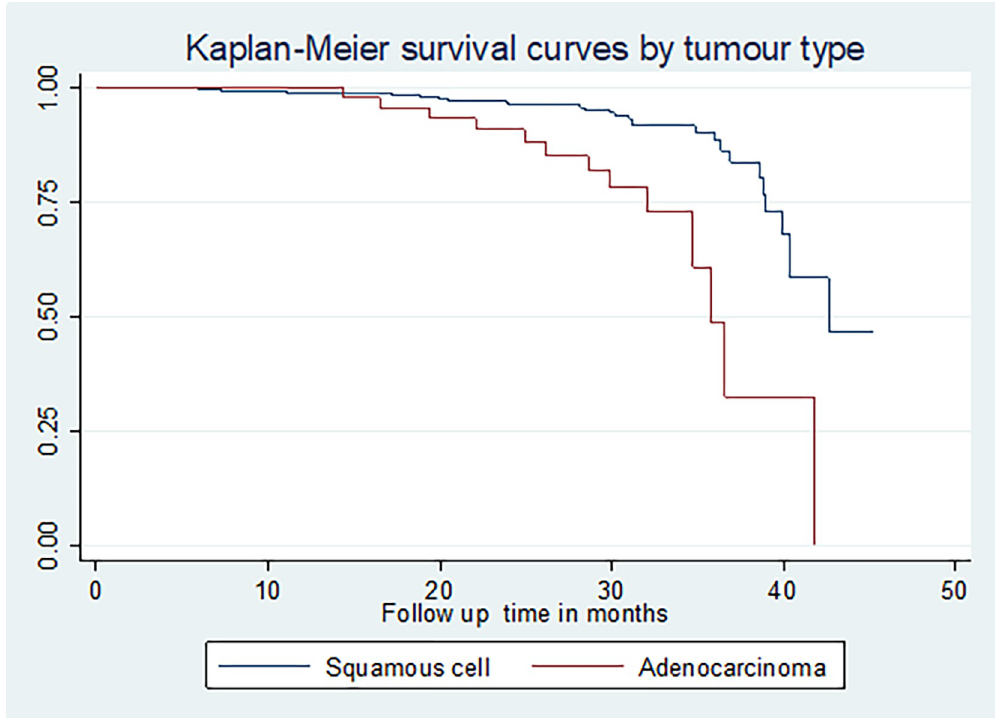
Fig 4. The Kaplan-Meier survival curves comparing survival time of cervical cancer patients by tumor type in Felege Hiwot Comprehensive Specialized Hospital Oncology Center, Ethiopia (N = 422, By Type of Histology, N = 422, March